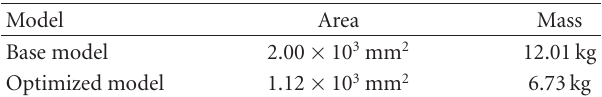
Table 4: The static analysis results for the base and optimized mod-